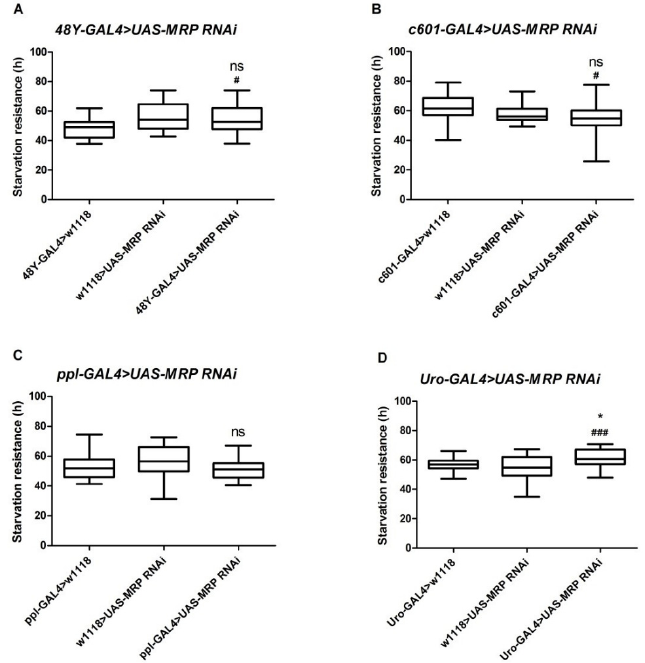
Figure 1. Crossing MRP RNAi with four different tissue-specific drivers. Graphs are presented in box plots, showing starvation resistance of both experimental and control groups. All Gal4 drivers were crossed with a UAS-MRP RNAi line: ( A ) 48Y-GAL4 (the mid-gut driver), ( B ) c601-GAL4 (the hind-gut driver), ( C ) ppl-GAL4 (the fat body driver), and ( D ) Uro-GAL4 (the Malpighian tubule driver). Error bar represents the max and min values, and 32 male flies were used for each individual crossed strain; ns, not significant compared to either w 1118 > UAS-MRP RNAi or both of the controls; # p < 0.01, compared to GAL4-driver > w 1118 ; ### p < 0.001, compared to Uro-GAL4 > w 1118 ; * p < 0.01, compared to w 1118 > UAS-MRP RNAi flies; one-way ANOVA with Tukey’s post hoc test was per- formed.